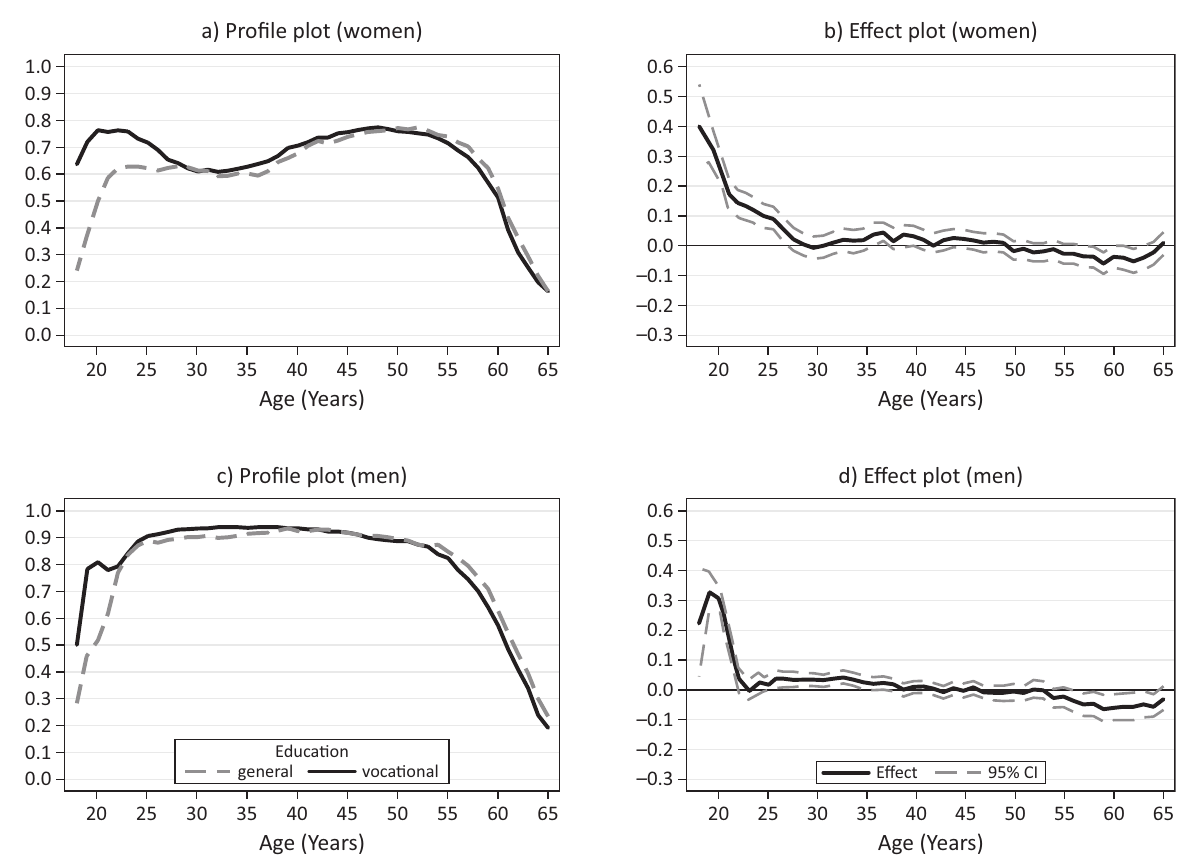
Figure 2. Employment opportunity over the life course: General versus vocational education by gender. Notes: Conditional profile plots (left) and conditional effect plots (right) estimated by gender-specific non-parametric state probability mod- els of vocational and general education on employment probabilities. Control variables include period effects, cohort ef- fects, German nationality, parental educational background, residence in West Germany, and educational level. N per- sons = 44,502; N person-years = 332,537. See Table A4 in the Appendix for detailed regression results. Data source: GSOEP